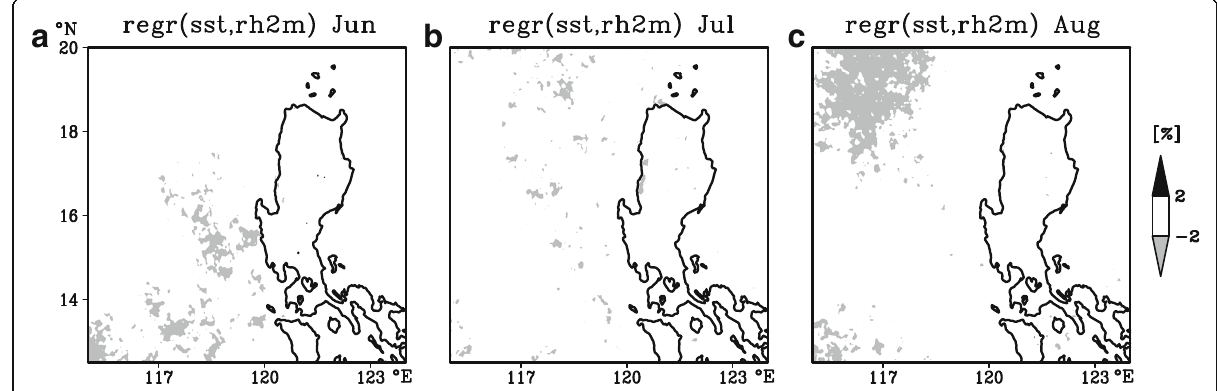
Fig. 8 Spatial map of the regression coefficients of the sensitivity of 2 m relative humidity (rh2m) to the monthly SST anomaly of the WSST reference region for 1982 – 2012 for the months of a June, b July, and c August. The values are shown in percentage relative to the 31 yr.-mean rh2m from CTL